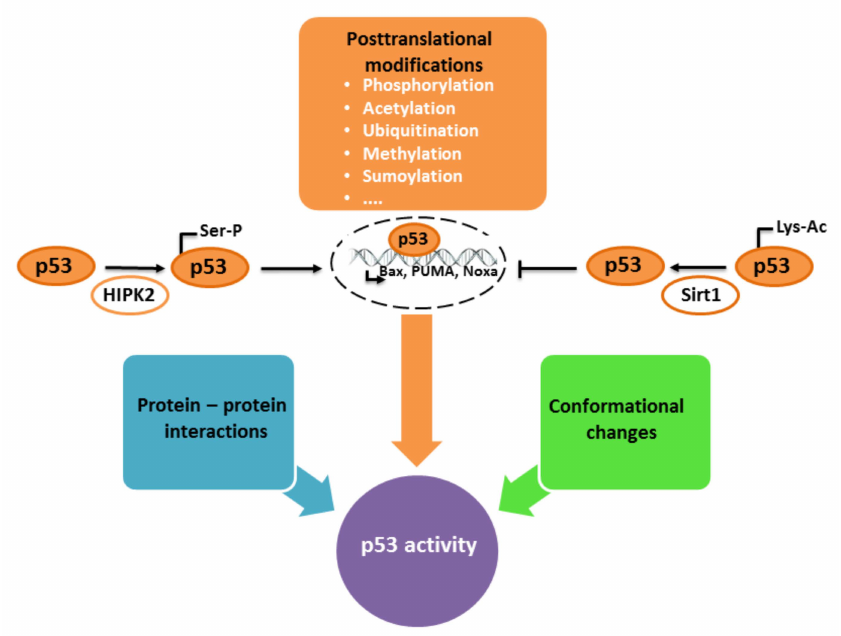
Figure 3. Regulation of p53 activity in physiological and neurodegenerative